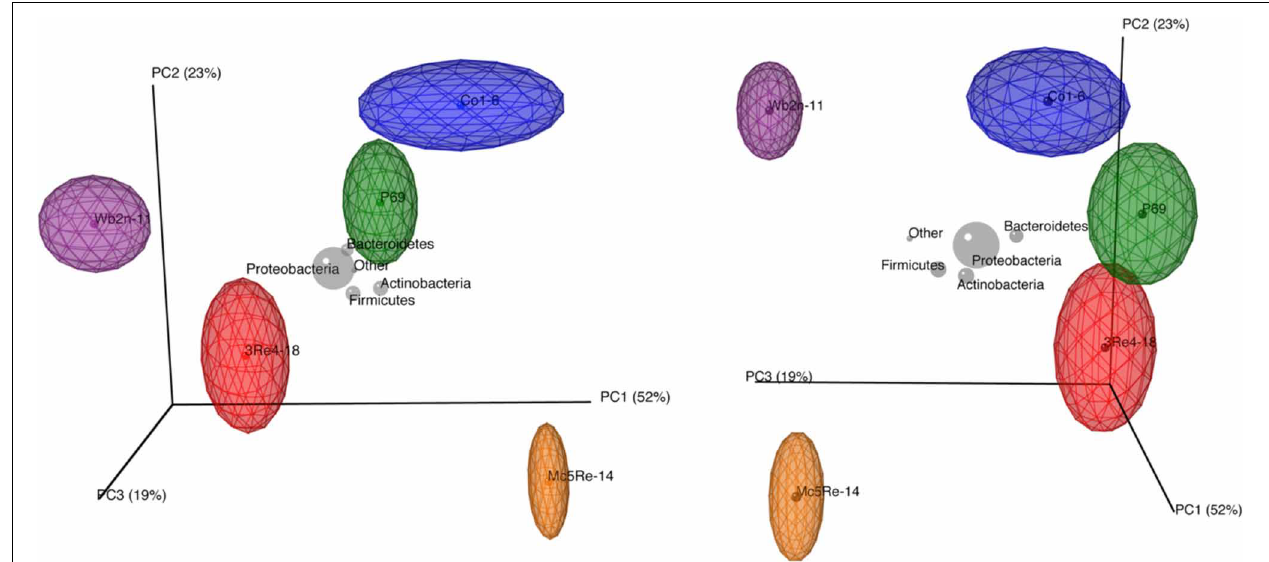
FIGURE 6 | Comparison of the microbial communities of Chamomilla recutita (L.) Rauschert rhizosphere by jackknifed principal coordinate analysis. The biplot illustrates the compositional similarity between samples based on weighted UniFrac. Taxa coordinates are indicated by gray orbs with size, as a function of relative abundance. To confine the biplot, the number of